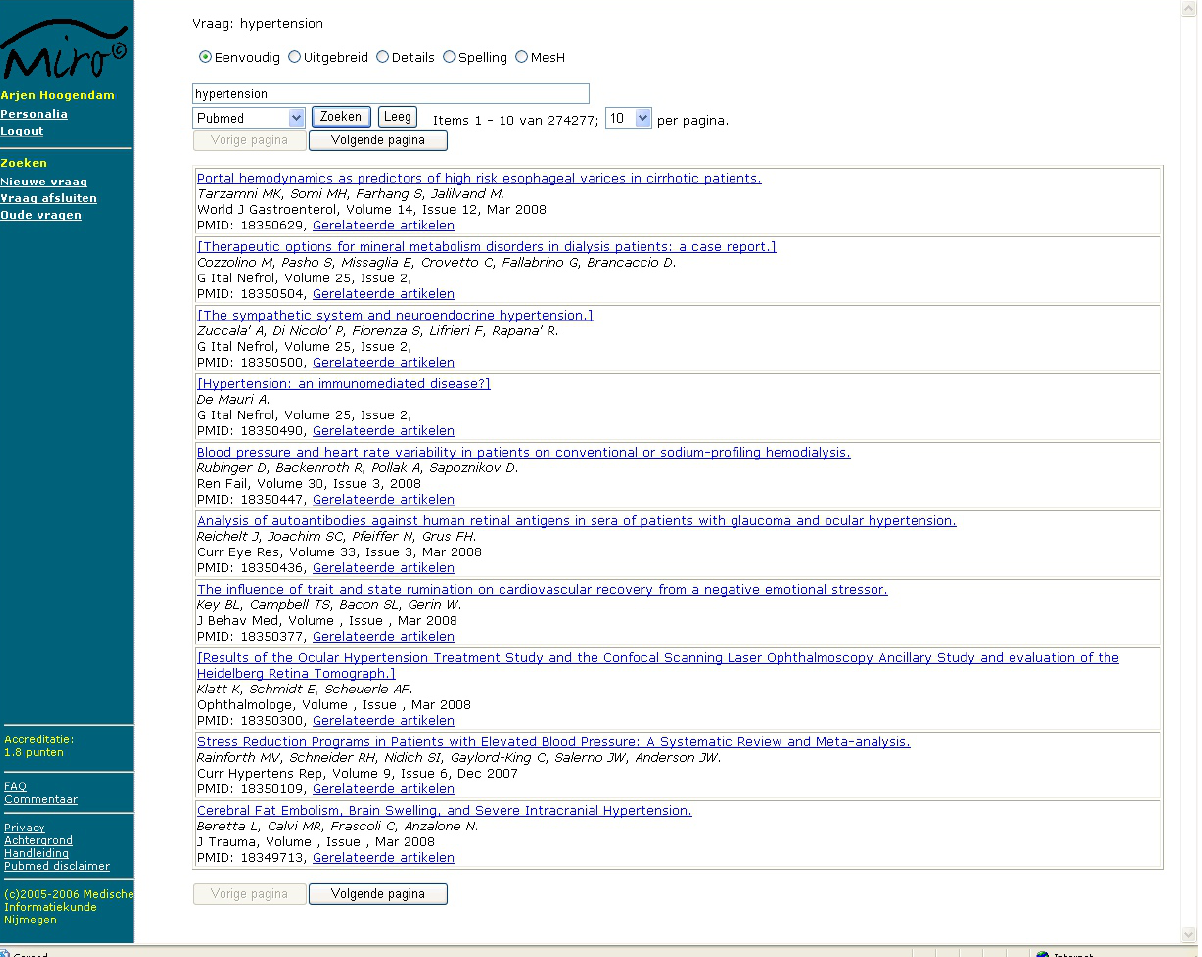
Figure 2. Screenshot of the portal: PubMed search result for